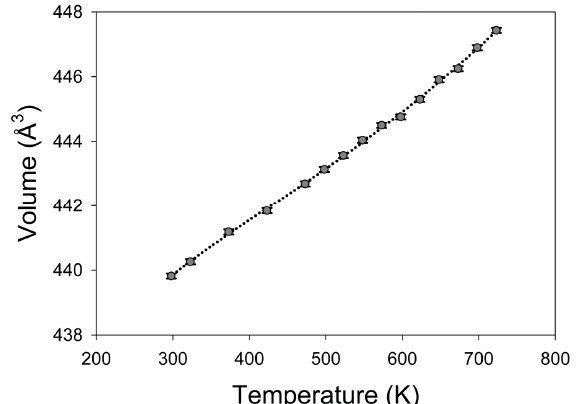
Figure 6. Measured unit cell volumes for bastnäsite-(La), as a function of temperature from 298 K to 723 K. The dotted black line is the fit for the Fei thermal equation of state [40].